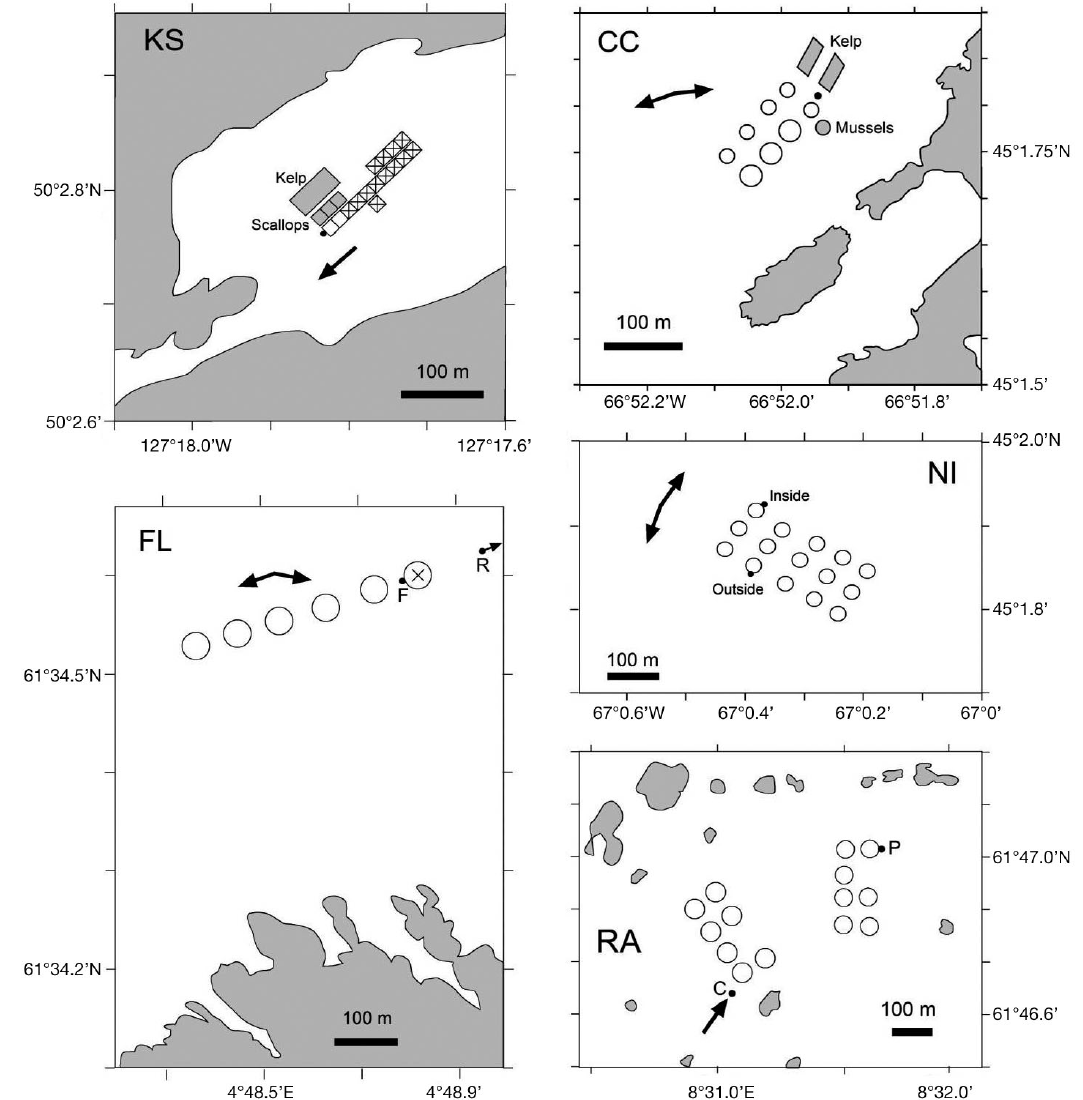
Fig. 1. Navy Islands (NI), Charlie Cove (CC) and Kyuquot Sound (KS) study sites in Canada, and the Rataran (RA) and Flåte- grunnen (FL) study sites in Norway. Fish net-pens are represented by open symbols; shaded symbols indicate net-pens for other taxa; closed circles show the locations of instrument moorings or profiling stations. Pens not containing fish are indicated by an ‘x’. The arrows show prevailing current directions during flood and ebb tides. The reference site (R) at the FL farm was located 1 km to the east of the farm site (F). Profiling (P) and current meter (C) locations are identified for the RA